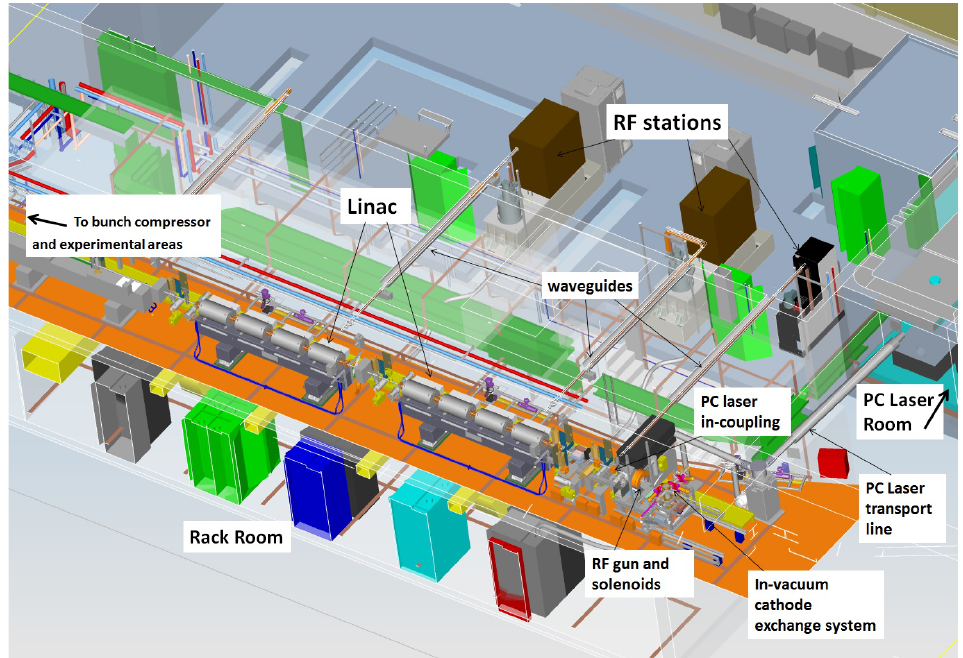
Figure 14. The ARES linac and the associated infrastructure in the former DORIS